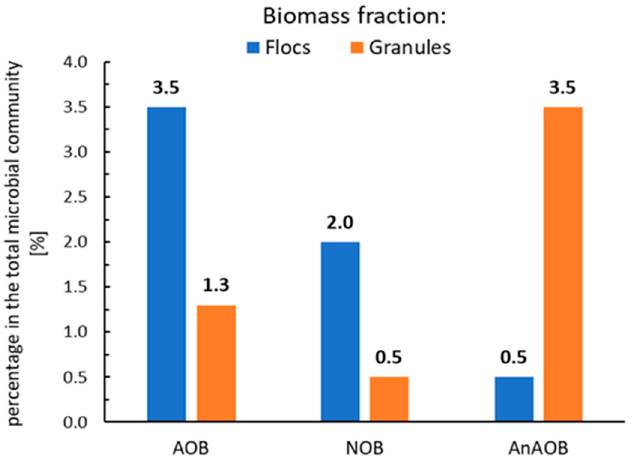
Figure 7. The abundance of different bacteria under the presence of flocs and granules based on [141]. Table 5. The introduction of different biomasses retention strategies in